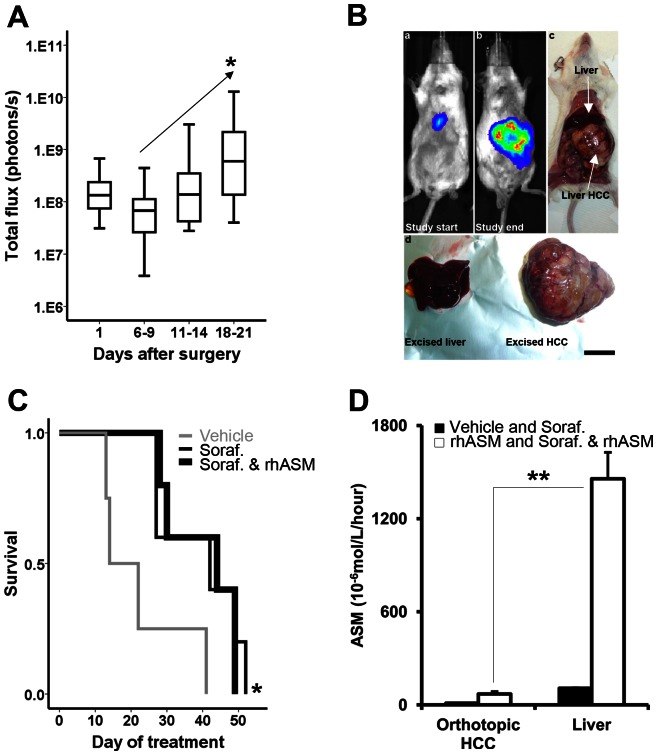
Orthotopic model of Huh7 tumors confirms the findings of rhASM/sorafenib treatment observed in subcutaneous Huh7 xenografts.(A) After surgical injection of luciferase-labeled Huh7 cells, luminescence was monitored over time. Increase in luminescence ≥6 fold baseline (day 1) was used as evidence of successful implantation of cells, initiation of tumor growth and a point of randomization of mice into treatment groups. (B) Representative images of mice at the beginning of drug treatment showing well detectable luminescence from the liver (insert a), large luminescent area corresponding to the liver Huh7 tumor at the time of sacrifice (inserts b,c). Liver and tumor were excised and separated (d) for further processing. Scale bar in insert d is 1 cm. (C) Significantly longer median survival of sorafenib treated mice (n = 5, 42 days, chi-square 4.88, df (1), p = 0.027) and combined rhASM/sorafenib treated mice (n = 5, 44 days, chi-square 4.43, df (1), p = 0.035) was observed compared to control (n = 4, 14 days). No significant difference was observed between rhASM alone (n = 4, 19 days) and control or between sorafenib and rhASM/sorafenib. (D) rhASM activity in orthotopic HCC from vehicle and sorafenib treated mice (naïve to rhASM treatment; baseline rhASM) was significantly, 6.4±1.4 fold, lower than rhASM activity in tumors from rhASM and rhASM/sorafenib treated mice (t = −3.99, df (15), p = 0.001). Similarly, baseline rhASM in the liver was significantly lower, 13.6±1.6 fold, than activity of rhASM in livers of mice receiving rhASM or rhASM/sorafenib (t = −9.07, df (14), p = 3.1· 10−7). Importantly, the difference between the activity of rhASM in treated mice (rhASM and rhASM/sorafenib) between orthotopic HCC and liver was much higher in the liver, 20.8±2.4 fold (t = −8.7, df (13), p = 8.8·10−7, **). Note: Y-axes activity (10−6 mol/L/hour) was measured in equal parts of 20% weight/volume tissue extracts as described in Materials and Methods.